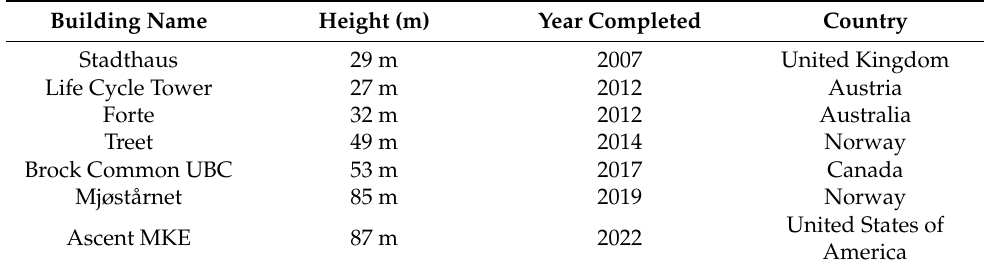
Table 1. Trend of timber/timber-hybrid building in the